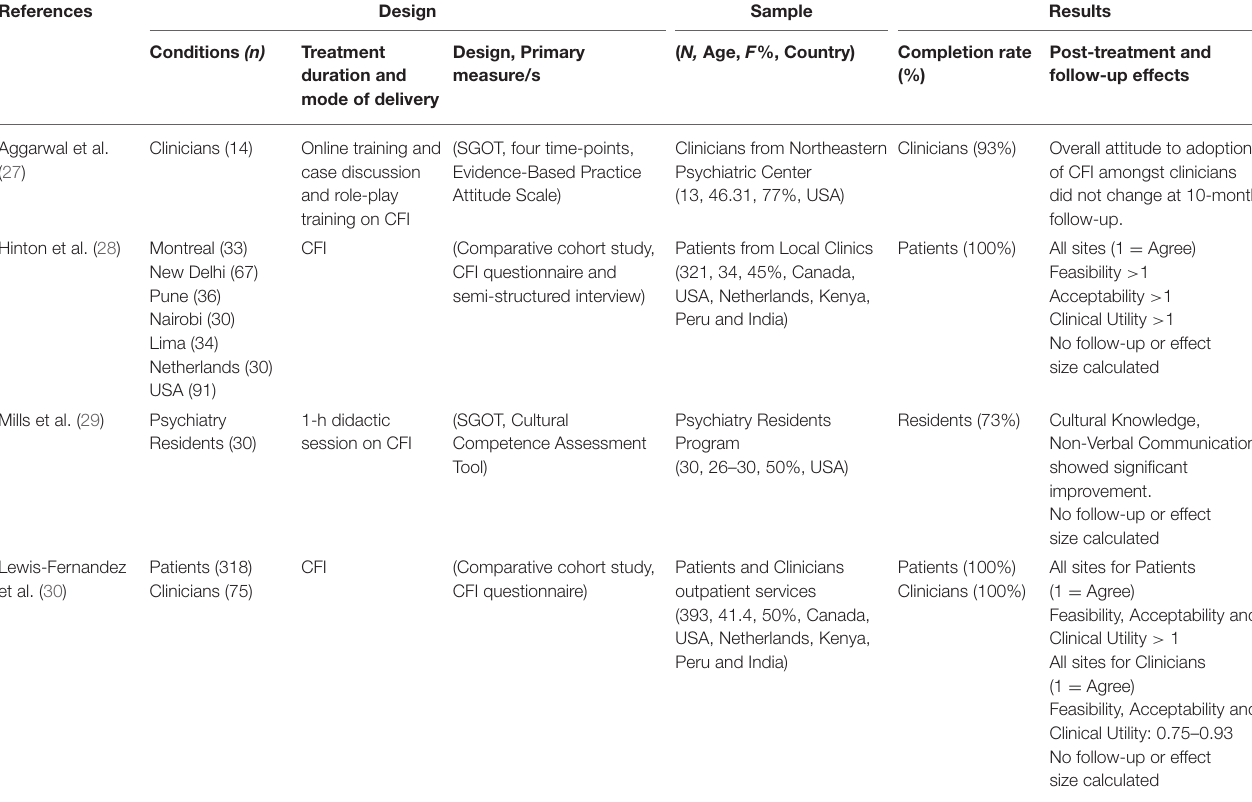
TABLE 2 | Summary of feasibility studies of CFI with a quality of evidence rating of